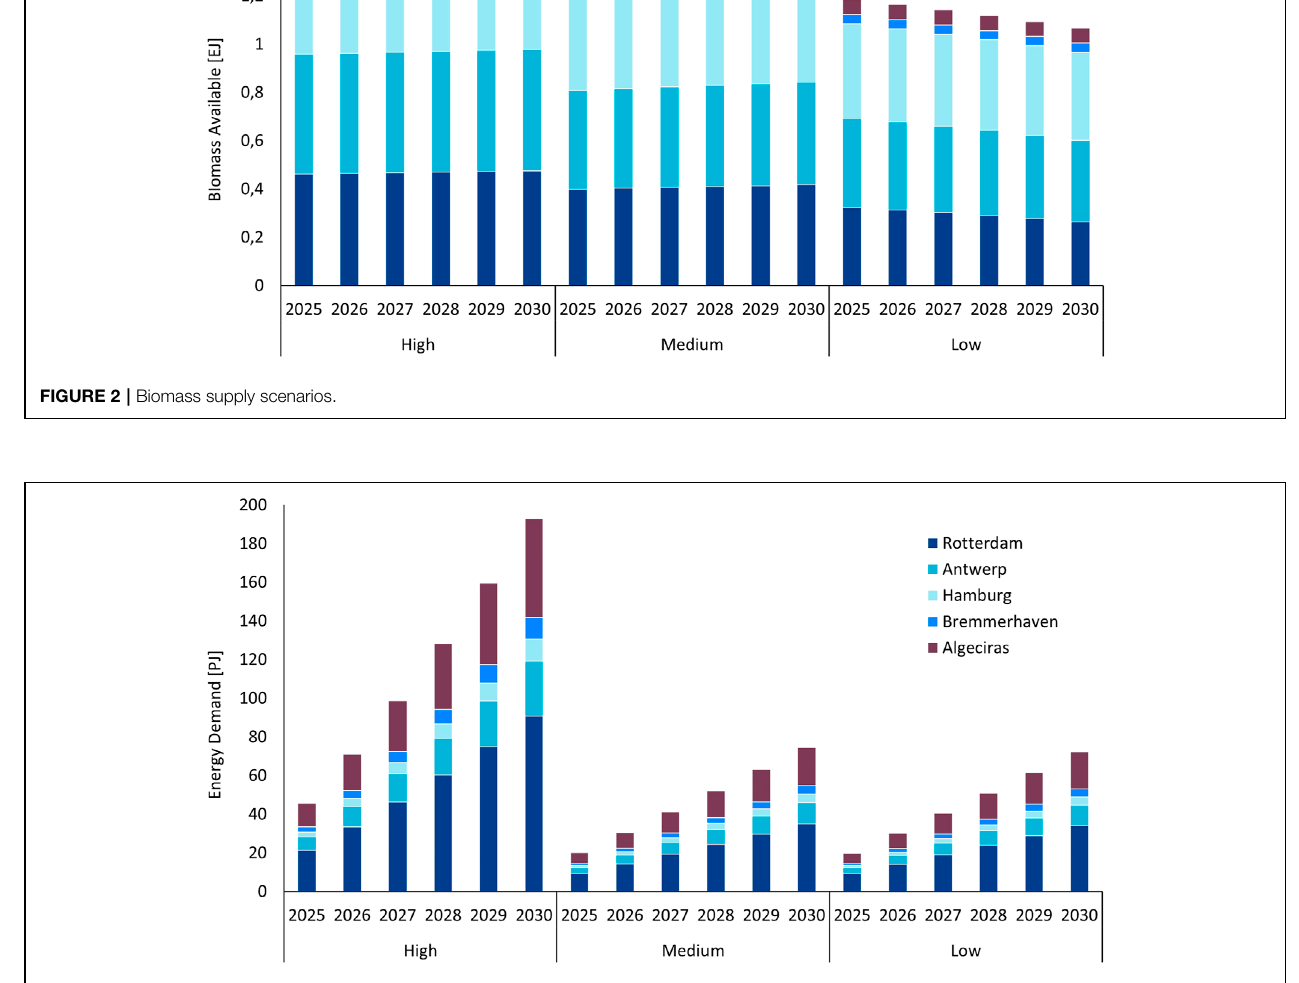
FIGURE 3 | Biomass demand